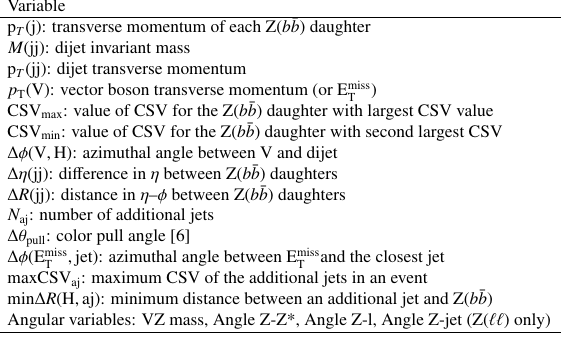
Table 2. Variables used in the BDT training.